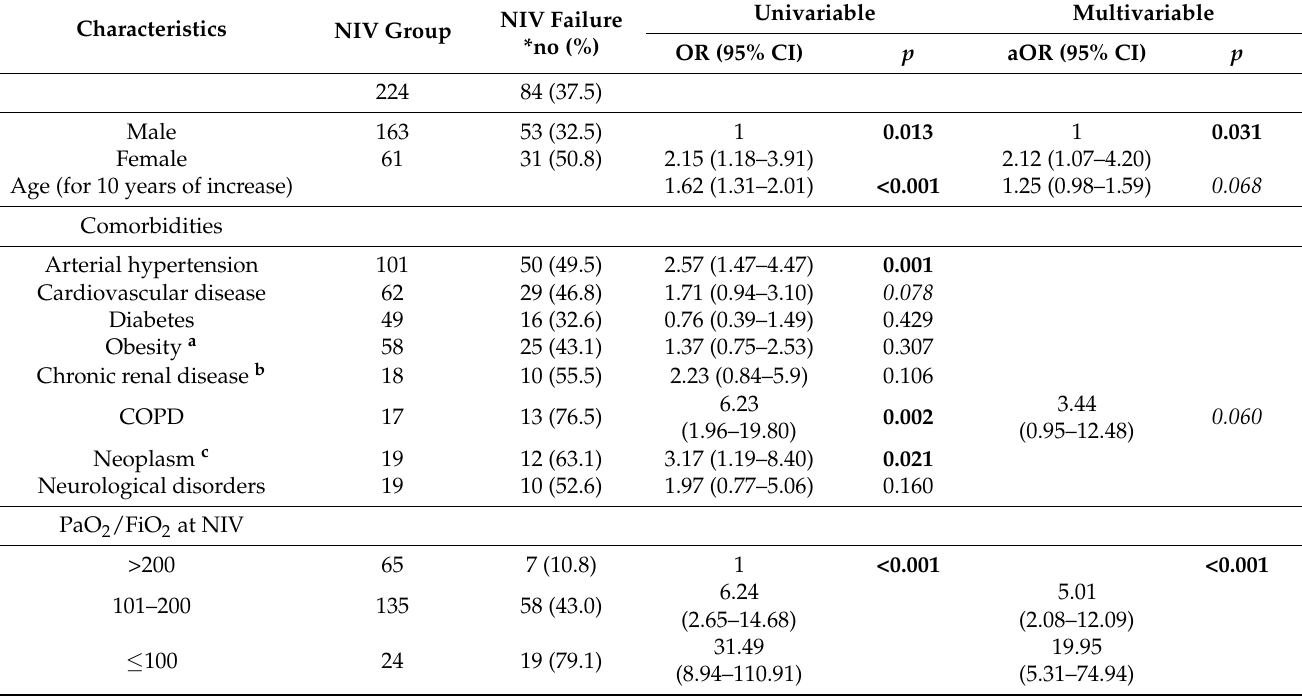
Table 2. Unadjusted and adjusted predictors of NIV